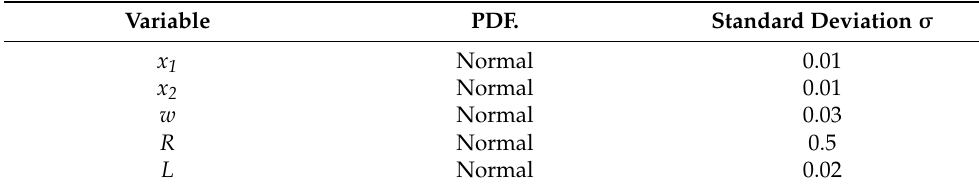
Table 9. Information of the random design variables of the cooling fan. Variable PDF.